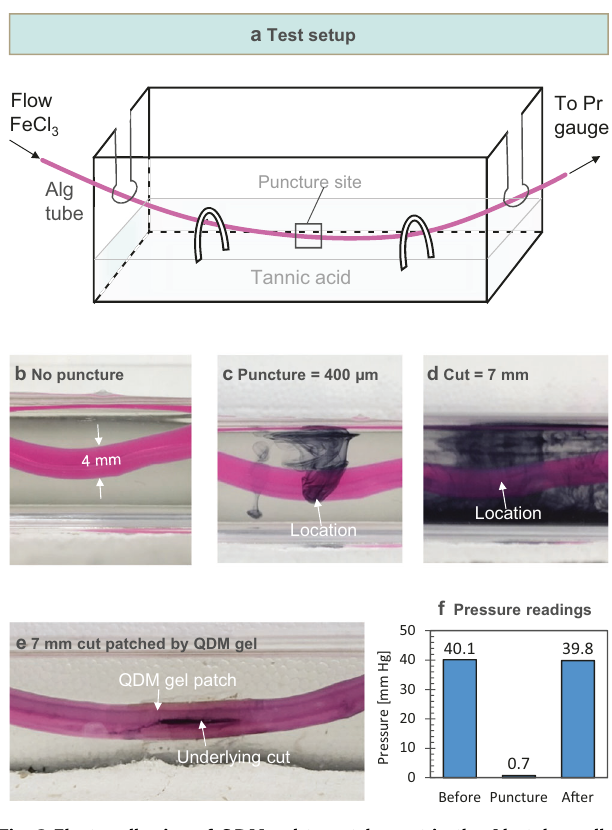
Fig. 3 Electroadhesion of QDM gel to patch a cut in the Alg tube wall. a Schematic of test setup. An aqueous solution of 0.1 wt% FeCl 3 is pumped through the lumen of the Alg tube, which is submerged in an aqueous bath of 0.1 wt% tannic acid. If the FeCl 3 leaks out of the tube, it reacts with the tannic acid and a black precipitate is formed immediately in the bath. b When the tube is intact, there is no leakage and the bath is clear. c Tube is punctured with a needle to create a hole of 400 µ m diameter. d Tube is cut to a length of 7 mm with a blade. In (C) and (D), as the fl uid in the tube leaks out, the black precipitate can be seen in the bath. e The tube from ( d ) is patched by a QDM gel, and when fl ow is resumed through the tube,